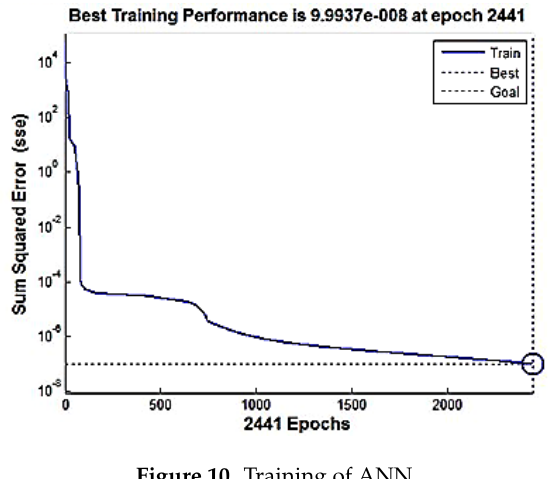
Figure 10. Training of ANN.